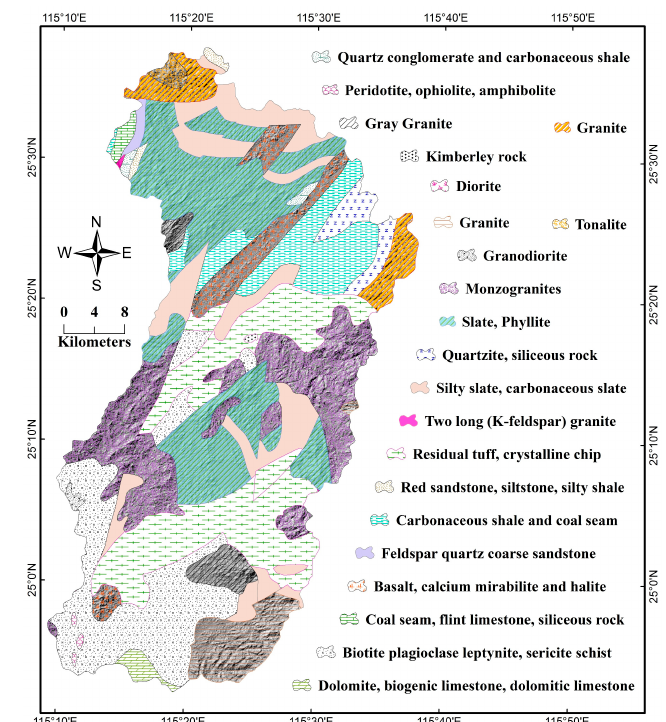
Figure 2. The geological map of the Anyuan County in China. Table 1. Geological formations of the study